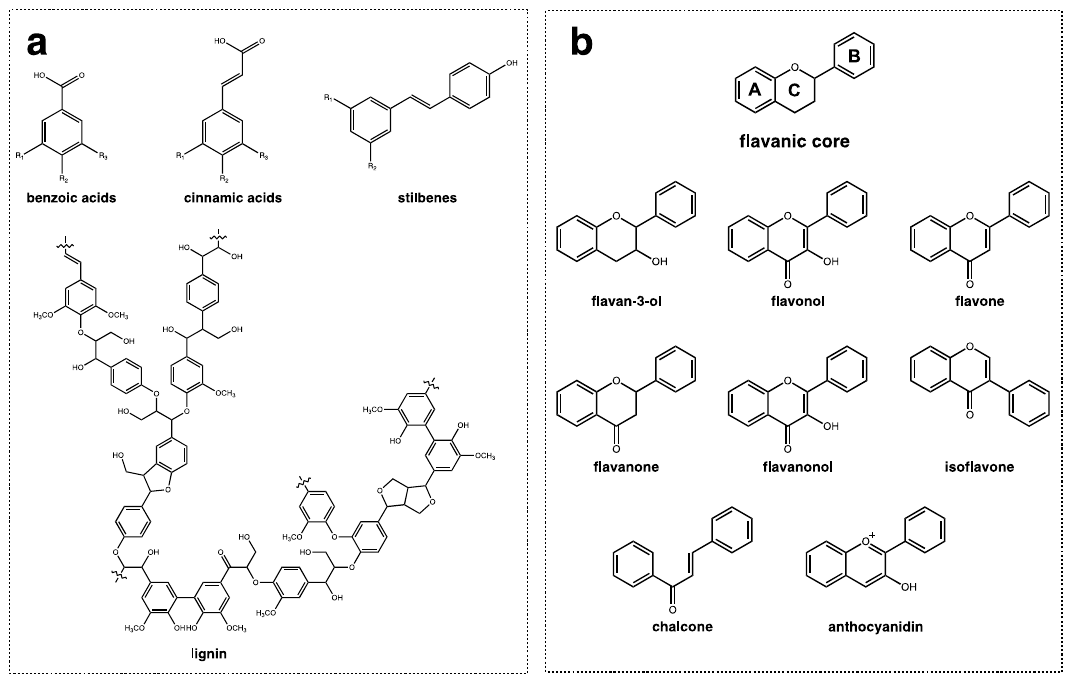
Figure 1. The general structure of phenolic compounds with ( a ) non-flavonoid compounds comprising benzoic, cinnamic acids, stilbenes, and lignins; and ( b ) flavonoid compounds represented by the flavanic core that is composed by two aromatic rings ((A) and (B)) and a pyranic ring (C) and their families of compounds: flavan-3-ol, flavonols, flavones, flavanones, flavanonols, isoflavones, chalcones, and anthocyanidins.